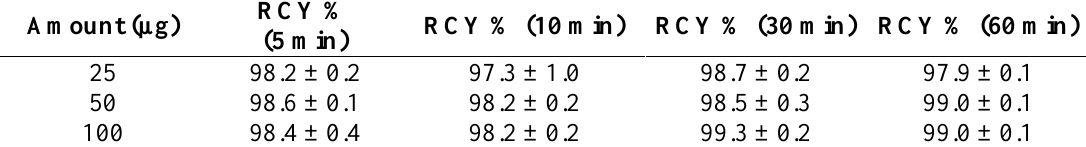
Table 2. Dependence of the RCY of [ 90 Y]Y-CHX-A''-DTPA-DUPA-Pep on peptide amount (concentration) and reaction time at room temperature.